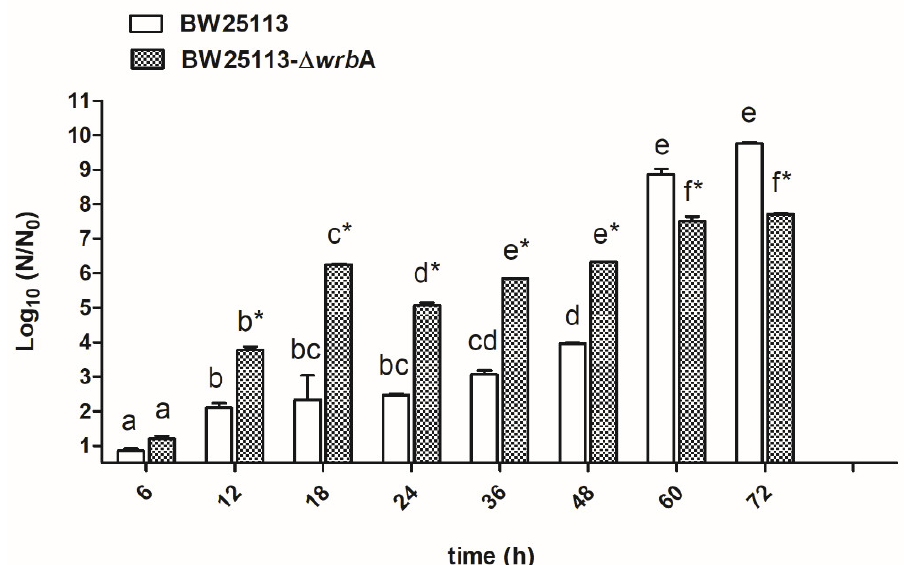
Figure 1. BW25113 and BW25113- ∆ wrb A biofilm growth curves. Data are expressed as log 10 (N/N 0 ), where N 0 is the CFU/cm 2 at the earliest time point and N is the CFU/cm 2 at time t. Data represent the mean ± standard deviation of three independent measurements. The letters above each column indicate statistically significant differences (Tukey’s HSD, p ≤ 0.05) at the corresponding time steps, whereas the asterisks indicate a significant difference between the two strains at the corresponding time step (t-test p ≤ 0.05).